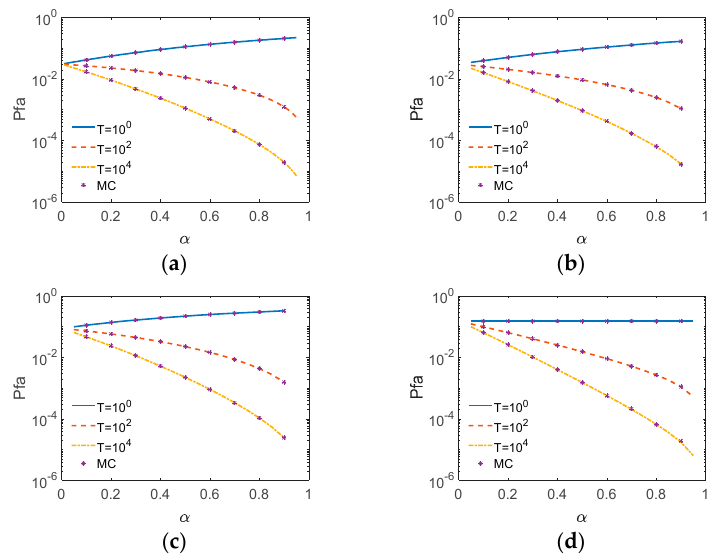
α α . The parameters are . The parameters are